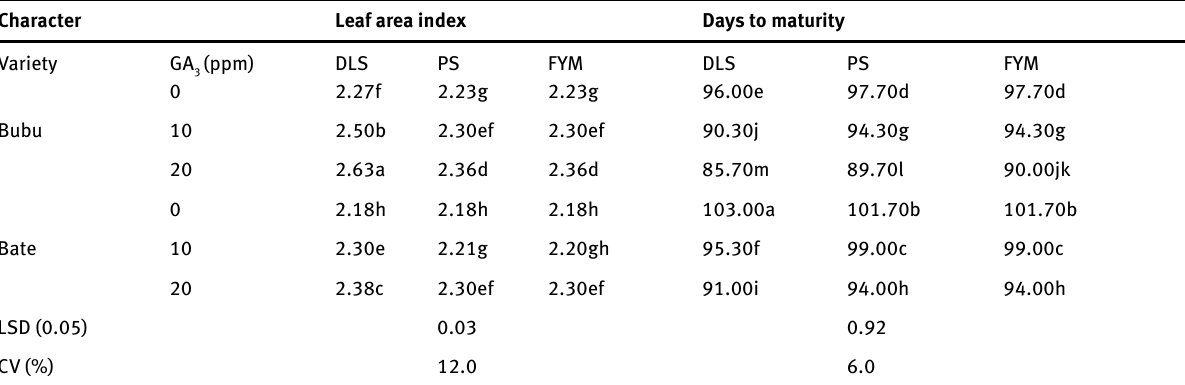
, and storage methods on leaf area index and 50% physiological maturity of two 3